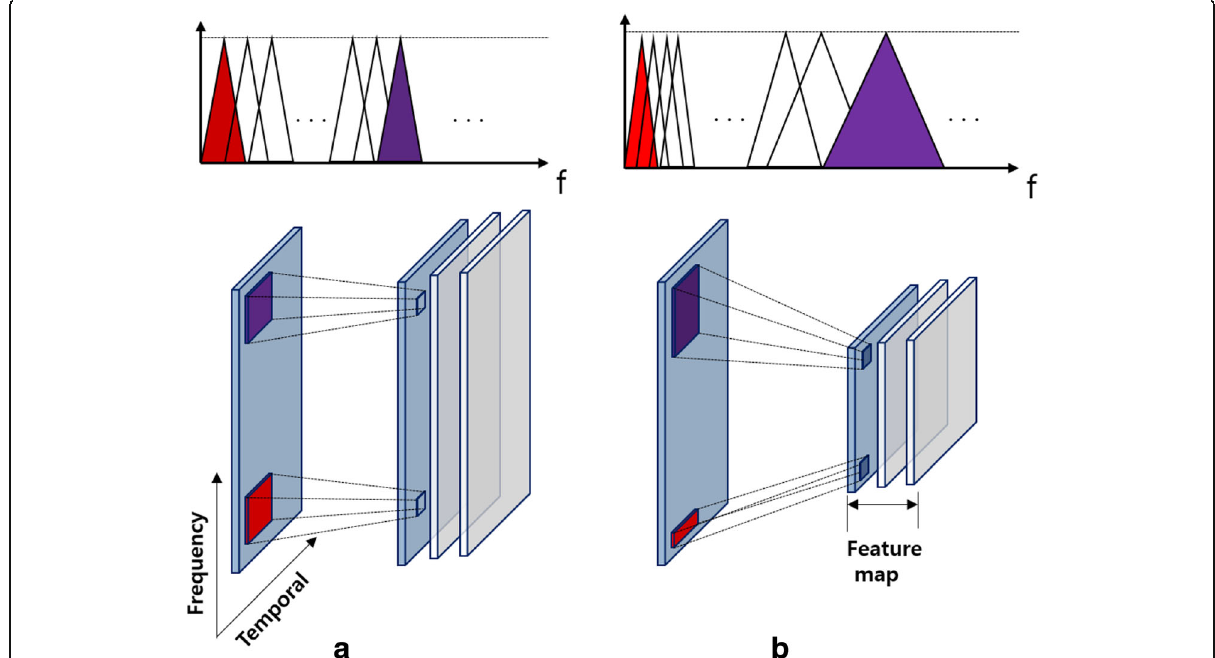
Fig. 5 Convolutional layers with a a fixed-size kernel and b a Mel-scale